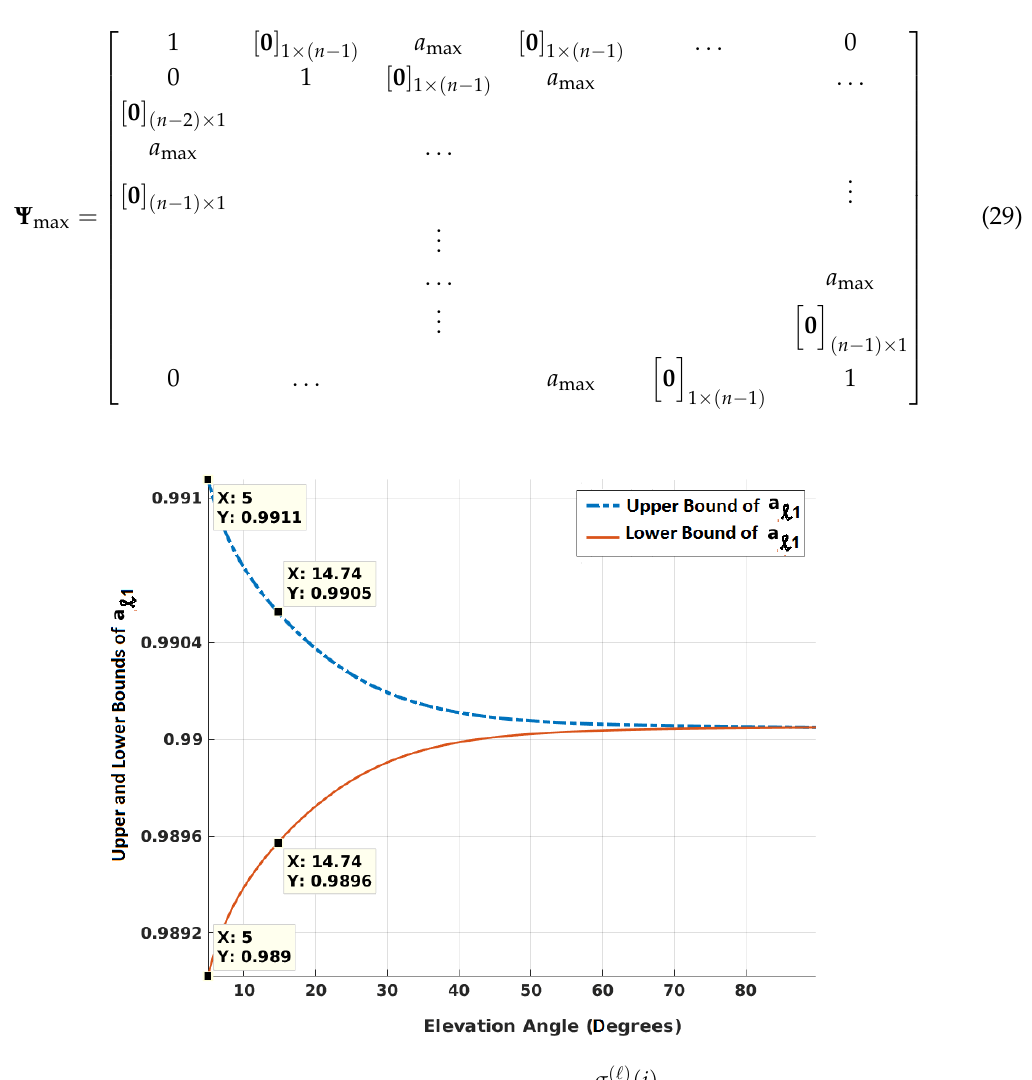
σ ( (cid:96) ) ( i ) for GPS satellites for different σ ( (cid:96) + 1 ) ( i )